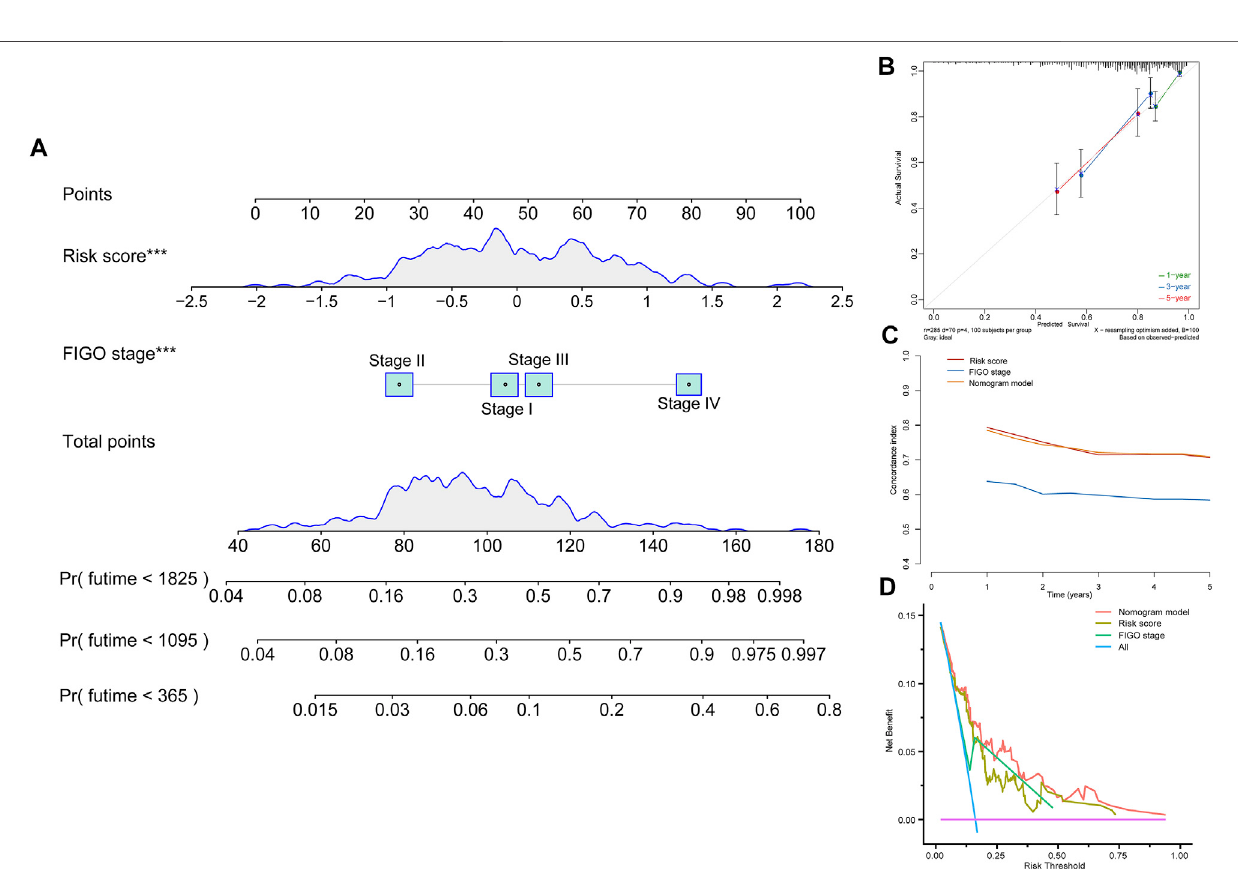
FIGURE4| Constructionofanomogrammodel. (A) NomogramconstructedinconjunctionwiththeriskscoreandFIGOstagefortheTCGAcohort. (B) Calibration plot of the nomogram. (C) C-index curves of the FIGO stage, risk score, and nomogram. (D) Decision curve analysis for evaluating the net bene fi ts of FIGO stage, risk score, and